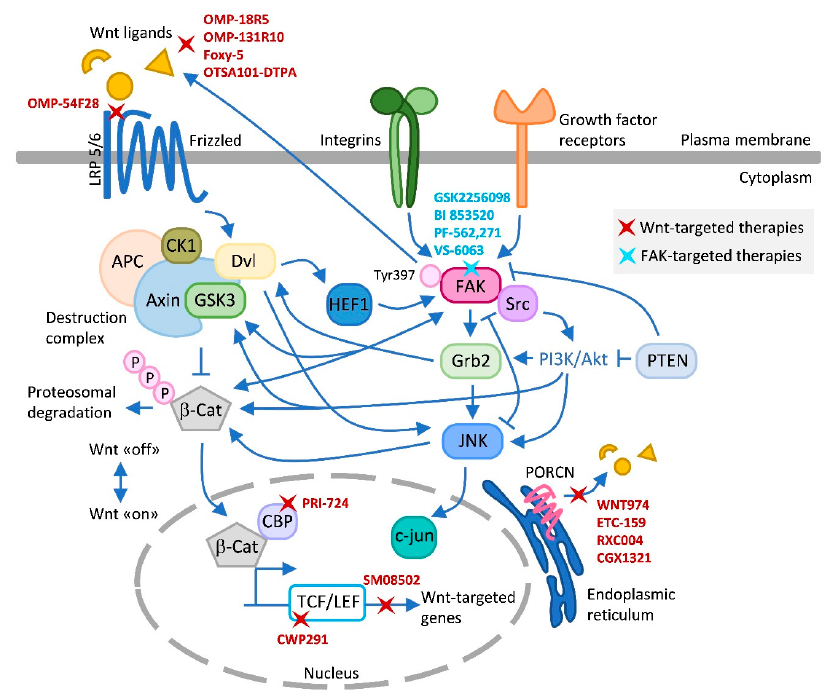
Figure 1. Wnt–FAK signaling crosstalks and inhibitors. This figure summarizes the main known crosstalks existing between Wnt and FAK that have been described in the text and in the literature, and the di ff erent Wnt and FAK inhibitors tested in clinical trials. Upon FAK activation, the FAK / Src complex phosphorylates and recruits several downstream signaling targets, including PI3K / AKT. GSK3 generally acts as a downstream signaling protein molecule of AKT [152]. Grb2 coordinates signaling downstream of integrin / FAK to activate JNK. Grb2 also interacts directly with Dvl [153]. Dvl can stimulate c-Jun-dependent transcription activity and the kinase activity of JNK [154]. Loss of PTEN function causes the activation of PI3K / AKT and JNK pathways [155]. PTEN also controls FAK [148]. FAK and PYK2 promote Wnt / β -catenin pathway activation by phosphorylating GSK3 β [74]. This phosphorylation inhibits the activity of GSK3 β which otherwise would drive rapid degradation of β -catenin. FAK increases expression of Wnt ligands activating Wnt signaling and CSC self-renewal indirectly or directly by activating β -catenin [102]. In addition, FAK was shown to trigger the β -catenin signaling pathway through nuclear translocation of β -catenin and transcriptional activation of β -catenin target genes [74]. FAK and Wnt have been described to modulate each other antagonistically [84]. HEF1 localizes to focal adhesions to coordinate FAK / Src signaling and is also modulated by Wnt [80]. Wnt-targeted agents include OMP18R5, OMP131R10, Foxy-5, OTSA101-DPTA, and OMP-54F28, which target Wnt signaling at the ligand / receptor level; PRI-724, CWP291, and SM08502 at the transcriptional level; and the Porcupine inhibitors WNT974, ETC-159, RXC004, and CGK1321, which block Wnt ligand secretion. FAK inhibitors include GSK2256098, PF-562,271, and VS-6063, which competitively target the ATP-binding site K454, located in the kinase domain of FAK; and the competitive sca ff old inhibitor BI 853520, which binds to the hinge region of the kinase domain of FAK blocking the access of ATP to the ATP binding site [143]. Arrows ( ↑ ) indicate activation / induction, and blunt-ended lines (T) indicate inhibition / blockade. LRP, low-density lipoprotein receptor-related protein; Dvl, dishevelled; CK1, casein kinase 1; APC, adenomatous polyposis coli; GSK3, glycogen synthase kinase-3; β -Cat, β -catenin; CBP, CREB binding protein; TCF / LEF, T-cell factor / lymphoid enhancer factor; Grb-2, growth factor receptor-bound protein 2; PTEN, phosphatase and tensin homolog; JNK, c-Jun N-terminal kinase; PORCN,